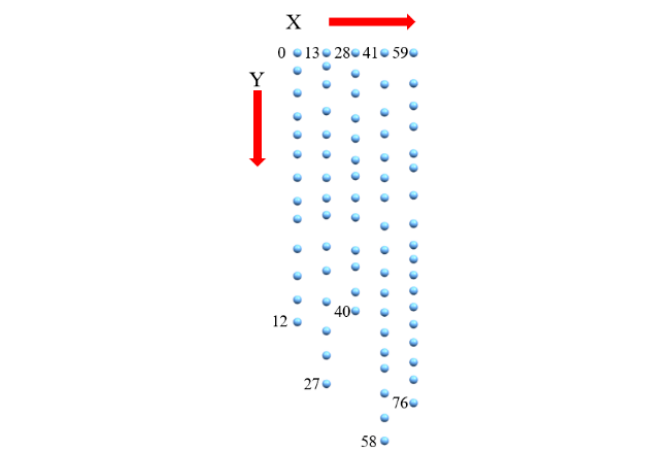
ur uur v v and . 1 2